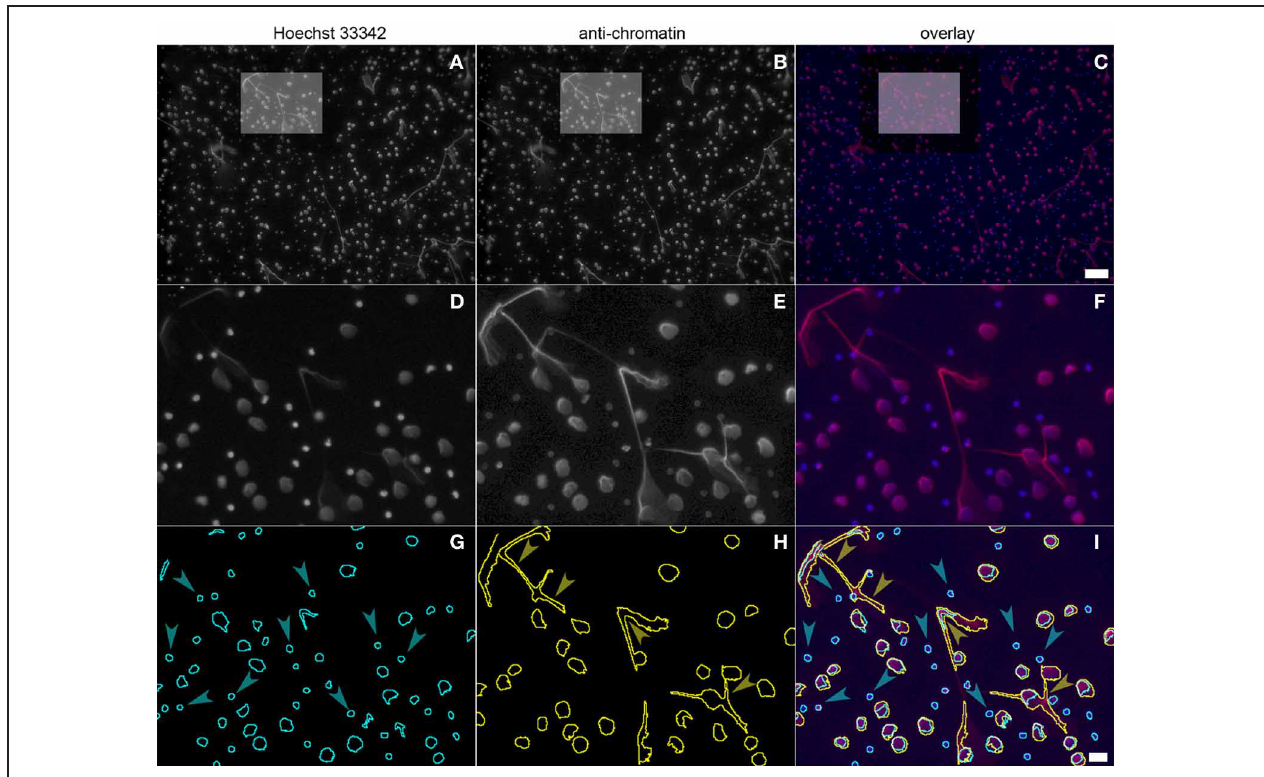
fluorescence signals is shown in panel 3G (blue, DNA) and panel 3H (yellow, chromatin). The overlay of the segmentations and the fluorescence signals is depicted in panel 3I . Bars represent 100 μ m for (A–C) and 20 μ m for (D–I) .